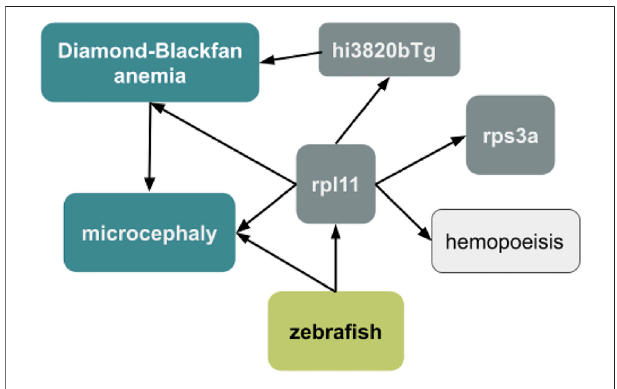
FIGURE 8 | Expanding a data set using a knowledge graph. The zebra fi sh endpoint “ microcephaly ” can be used to query the Monarch knowledge graph to fi nd relevant genes (rpl11 and rps3a), variants (hi3820bTg), diseases (Diamond-Blackfan anemia), and biological processes(hemopoeisis)toenrichthedatasetandgeneratenewhypotheses.